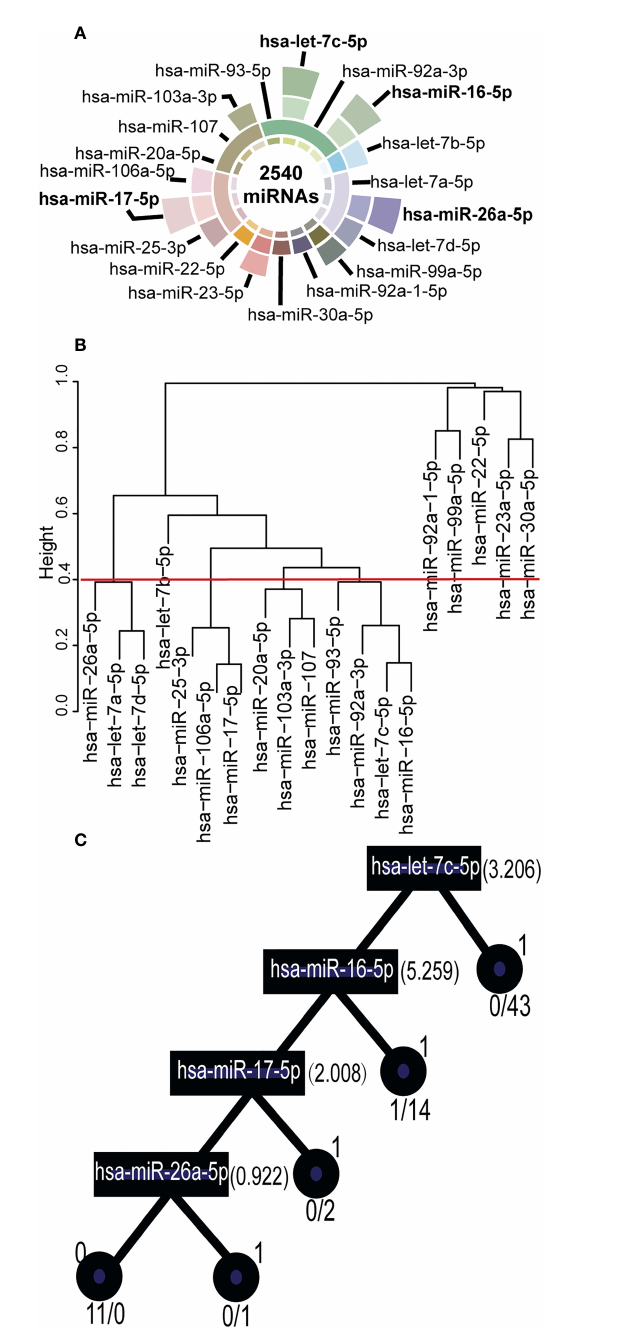
FIGURE 2 Key Synergistic Ser-miRNAs Serve as Biomarkers for BTC. (A) Filtered key synergistic ser-miRNAs. The center of a circle represented 2,540 ser- miRNAs in the internal data sets. From the center of the circle to the outside, the fi rst layer represented 19 differentially expressed ser-miRNAs that were identi fi ed by SAM. The second layer expressed the 10 co-expression ser-miRNA set using PCC. The third layer expressed 11 key ser- miRNAs that were selected using a t-test. The outermost layer represented four key synergistic ser-miRNAs that were identi fi ed by decision tree. (B) Clustered into co-expressed ser-miRNA sets by PCC. The 19 differentially expressed ser-miRNAs were clustered into 10 co-expressed ser-miRNA sets by PCC (r>0.6, P<0.05). (C) A decision tree was generated to further select the key synergistic ser-miRNAs. The squares represented ser-miRNAs: hsa-let-7c-5p, hsa-miR-16-5p, hsa-miR-17-5p, and hsa-miR-26a-5p and the split value was marked on the right. The circles represented the classi fi cation status of the samples, 1 represented BC samples, 0 represented healthy control